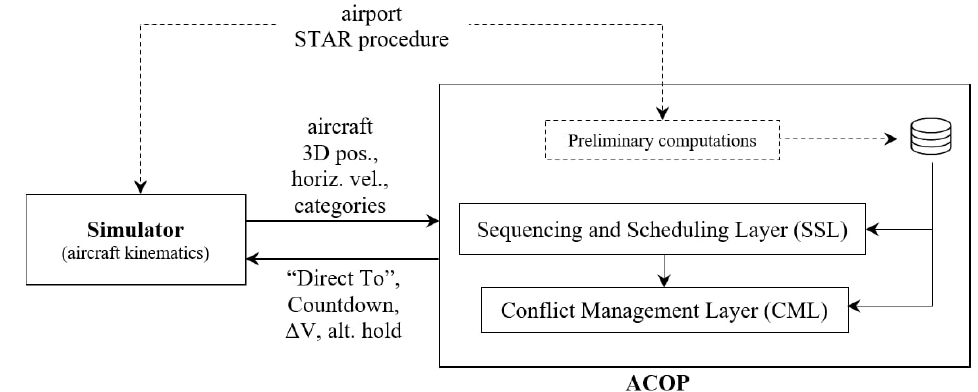
Figure 2. ACOP functional